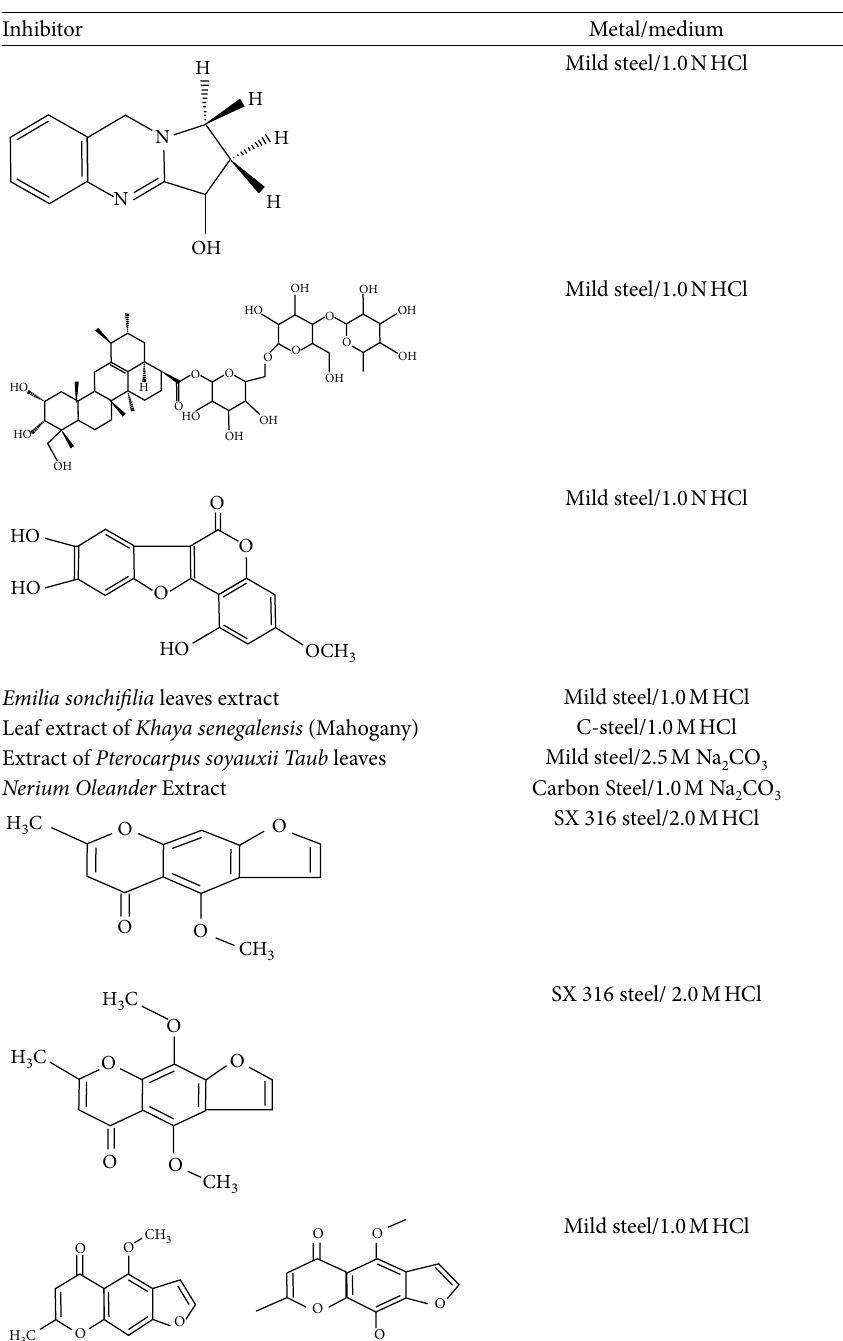
Table 6: Comparison of the inhibition efficiency of the seeds of Ammi visnaga with similar molecules studied